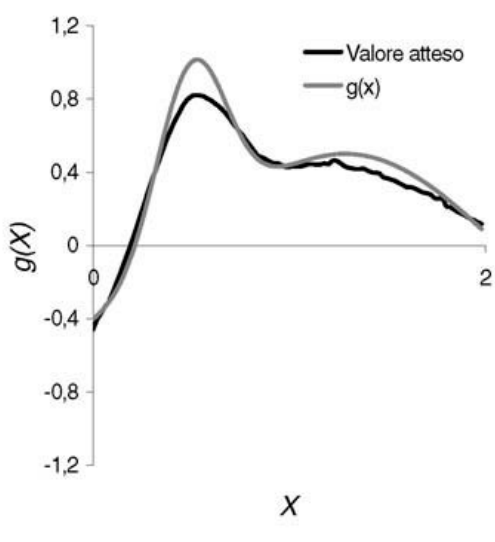
Figura 9 – Modello III: valore atteso del supersmoother.